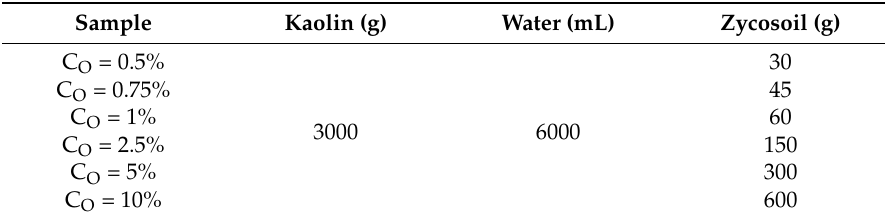
Table 2. Preparation of water-repellent clay.